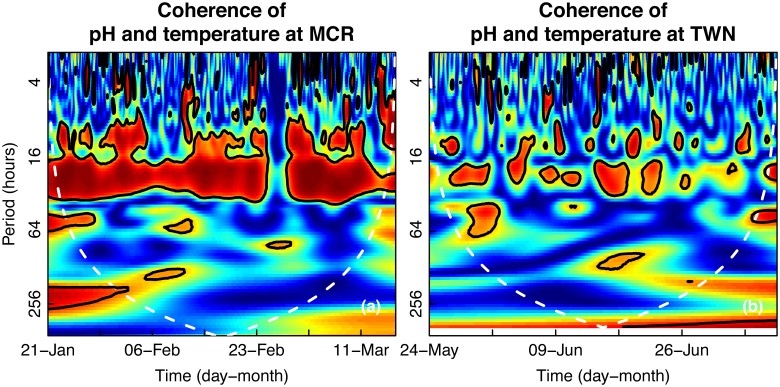
Correlation between pH and temperature fluctuations in seawater.Wavelet coherence, measuring the time-resolved correlation at each frequency or period for time series collected in (a) Moorea [MCR] and (b) Taiwan [TWN]. Warm colors indicate regions of high correlation, while cool colors indicate regions of low correlation. Black lines outline regions with significantly greater correlation.